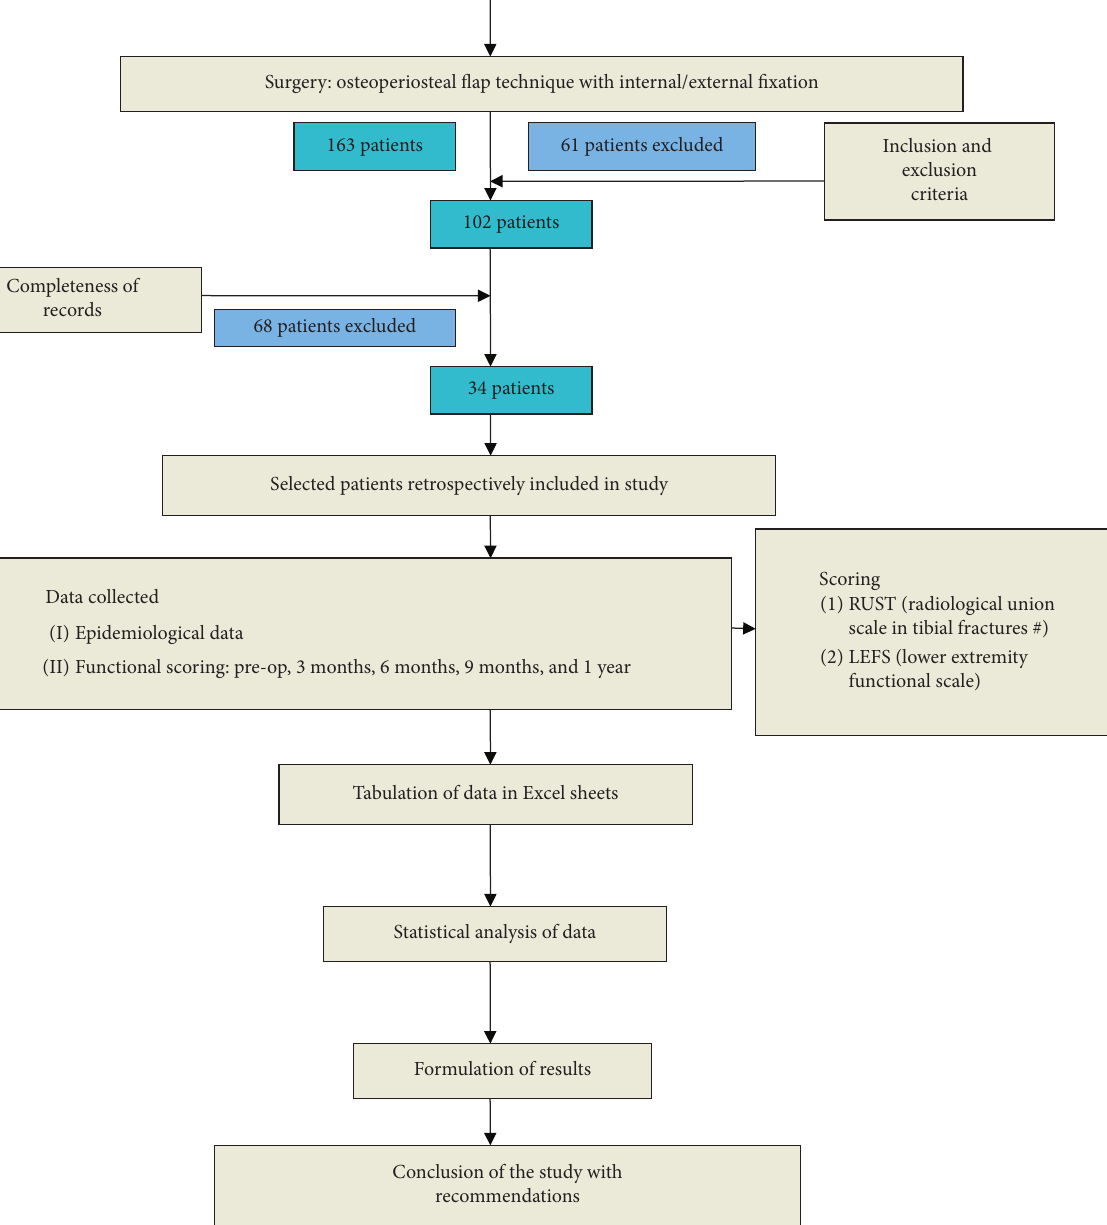
Figure 1: Methodology